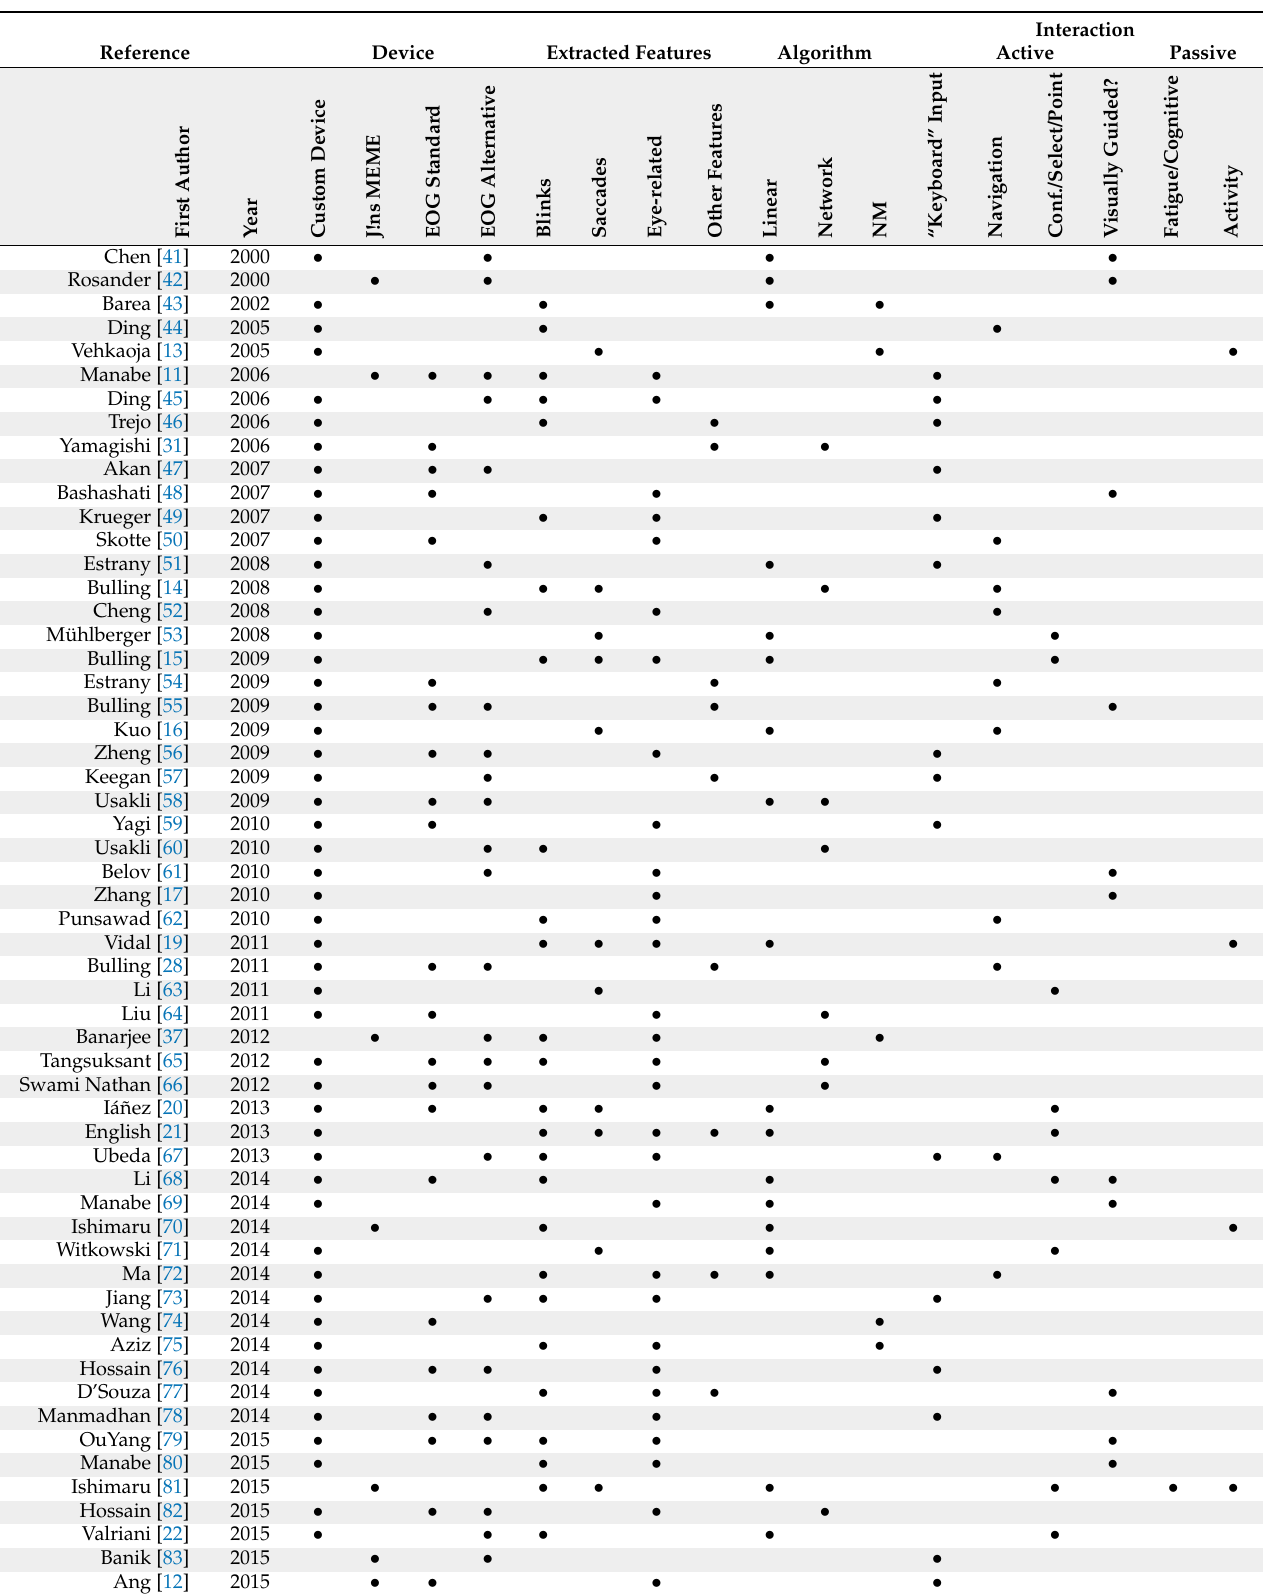
Table 1. Years 2000–2015. Pair rows are highlighted in gray for the ease of the